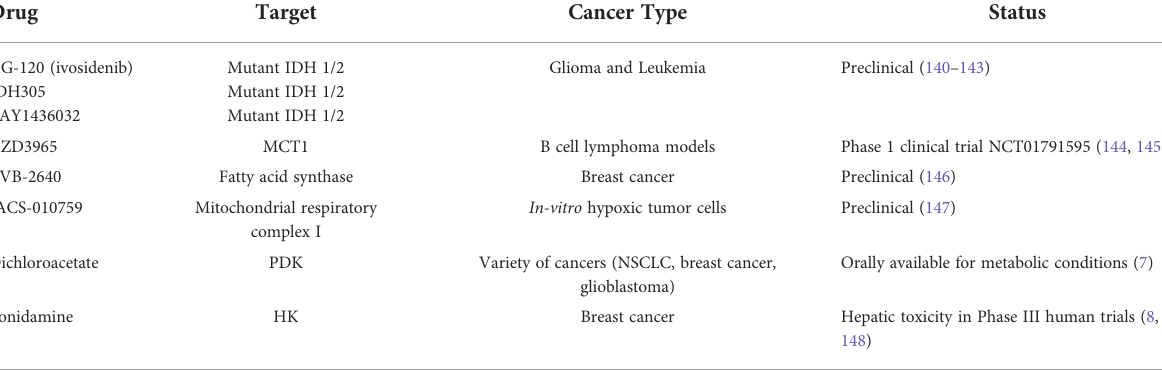
TABLE 1 Inhibitors of metabolic enzymes in (pre)clinical development among various cancer